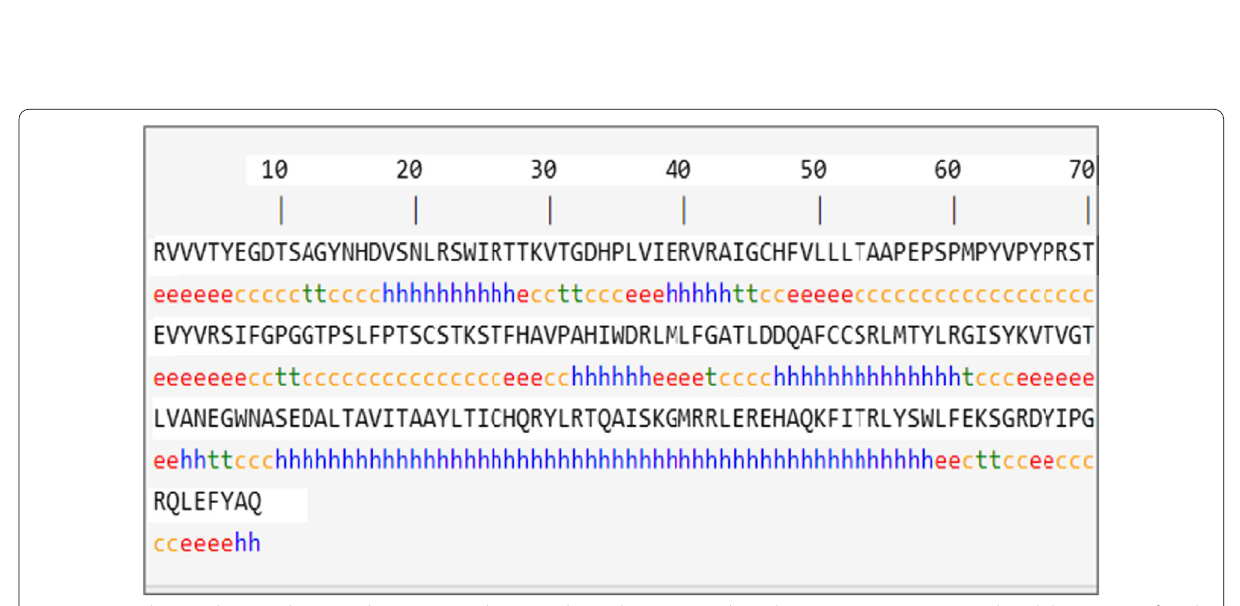
Fig. 5 HEV Y-domain showing the secondary structure elements. The analysis was conducted using SOPMA. SOPMA predicted that 40.37% of total amino acids contributed to alpha-helices, 20.64% to beta-strands and 32.57% to random coils